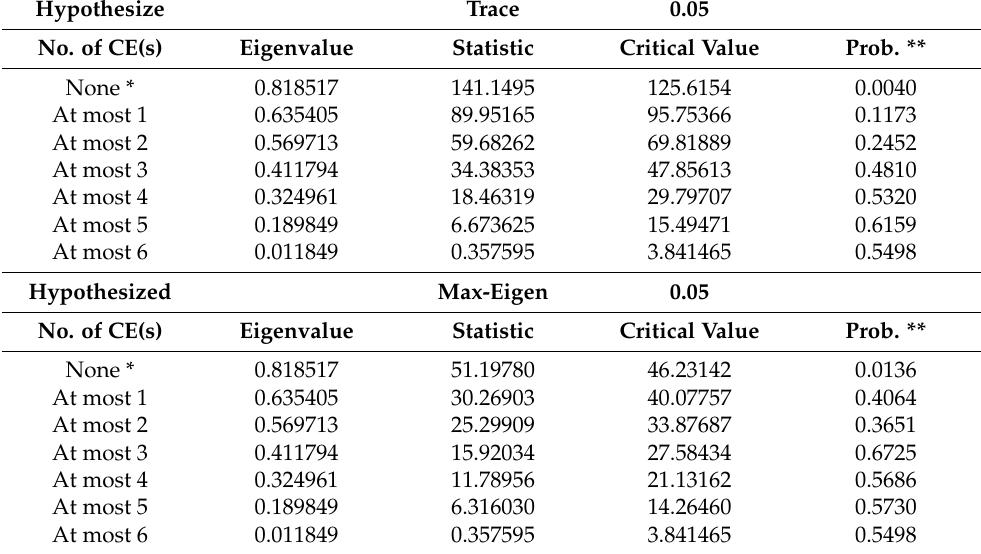
Table 3. Johansen co-integration